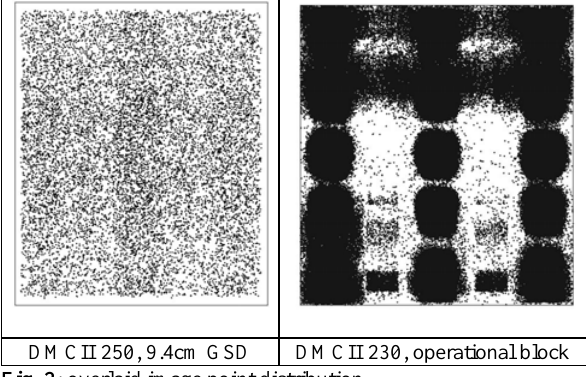
Fig. 2 : overlaid image point distribution The image point distribution of the DMCII-blocks is approximately equal with slightly over 200 points per image, while the in average 710 points per image of the operational block are not equal distributed (Fig. 2).